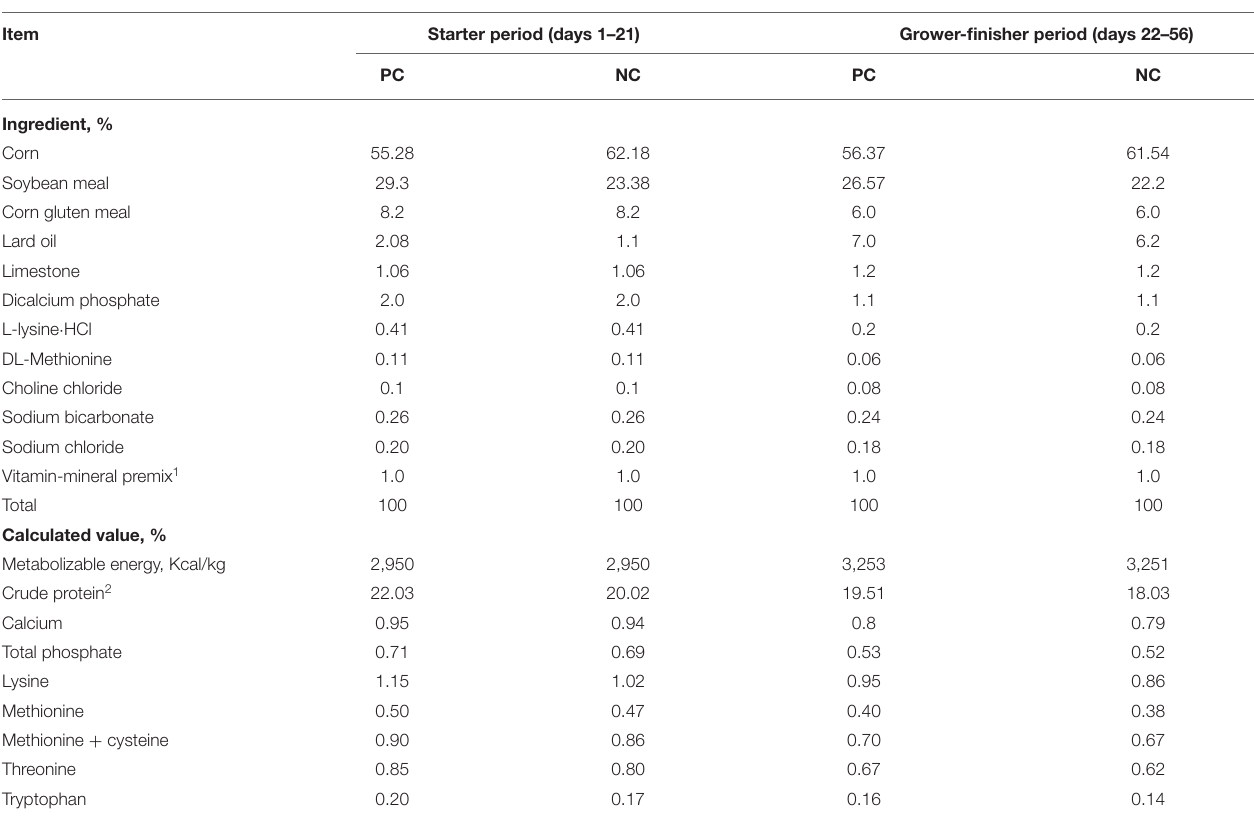
TABLE 1 | Composition and nutrient levels of the positive and negative control diets.